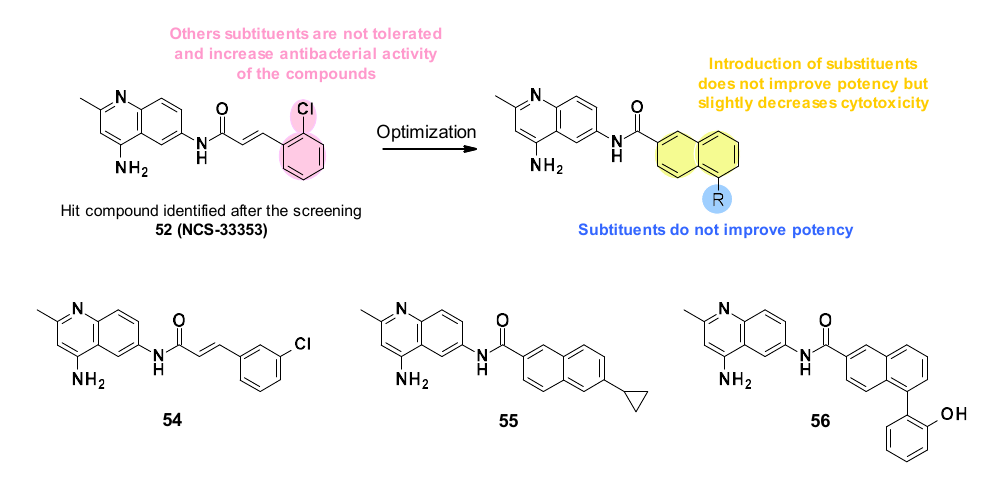
Figure 10. SARs summary and structures of compounds identified after SAR studies. The SARs allowed the discovery of three compounds (Figure 10).